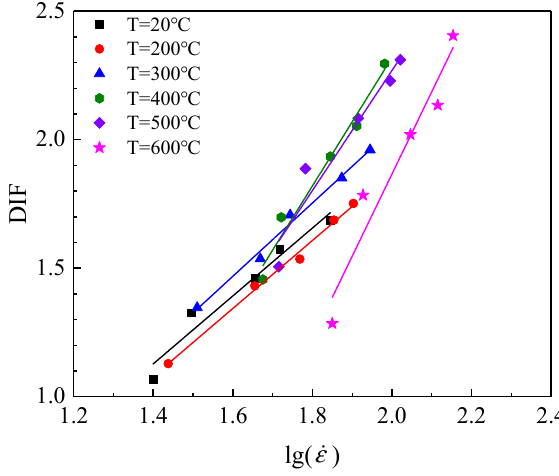
Figure 9. Relationship between DIF and lg(cid:4666)𝜀(cid:4662)(cid:4667) at different temperatures